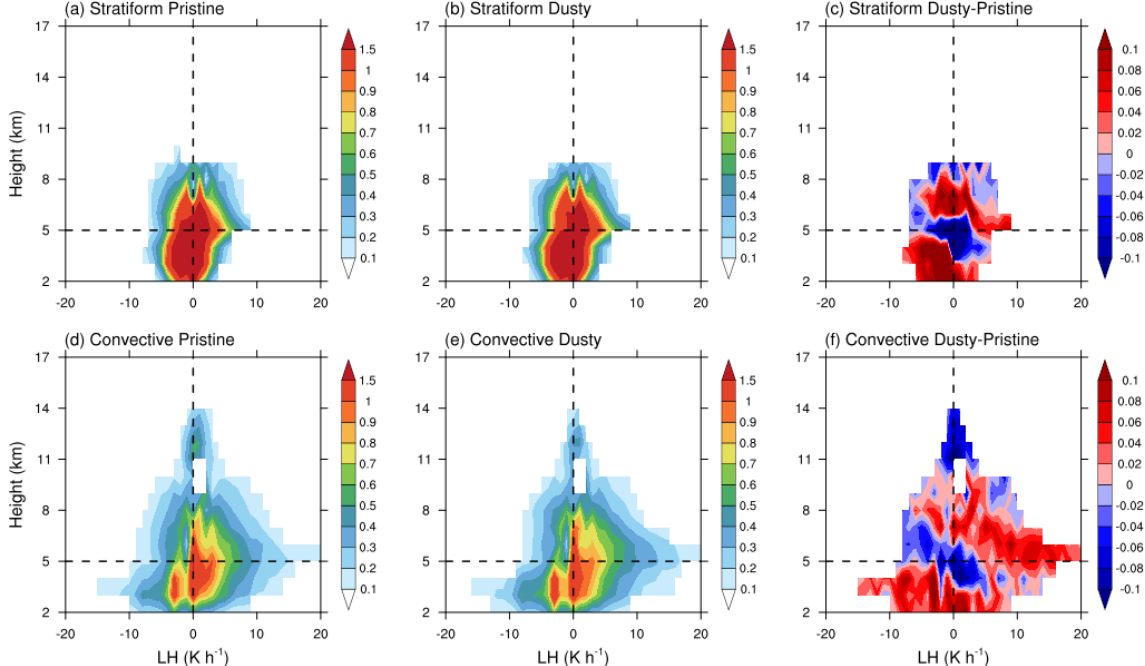
Figure 5. Contoured frequency by altitude diagrams (CFADs) of LH (retrieved using the VPH method) under pristine conditions (a, d) , under dusty conditions (b, e) , and the differences between the two conditions for (c, f) stratiform (a, b, c) and convective (d, e, f) precipitation.